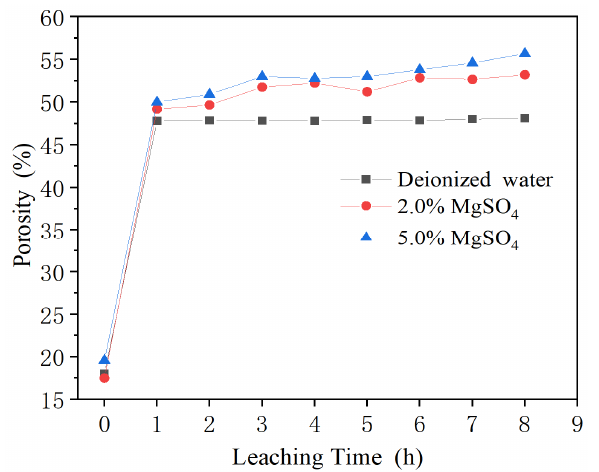
Figure 7. Variation of porosity of specimens in different concentrations of MgSO 4 and DI water leaching solution with leaching time.